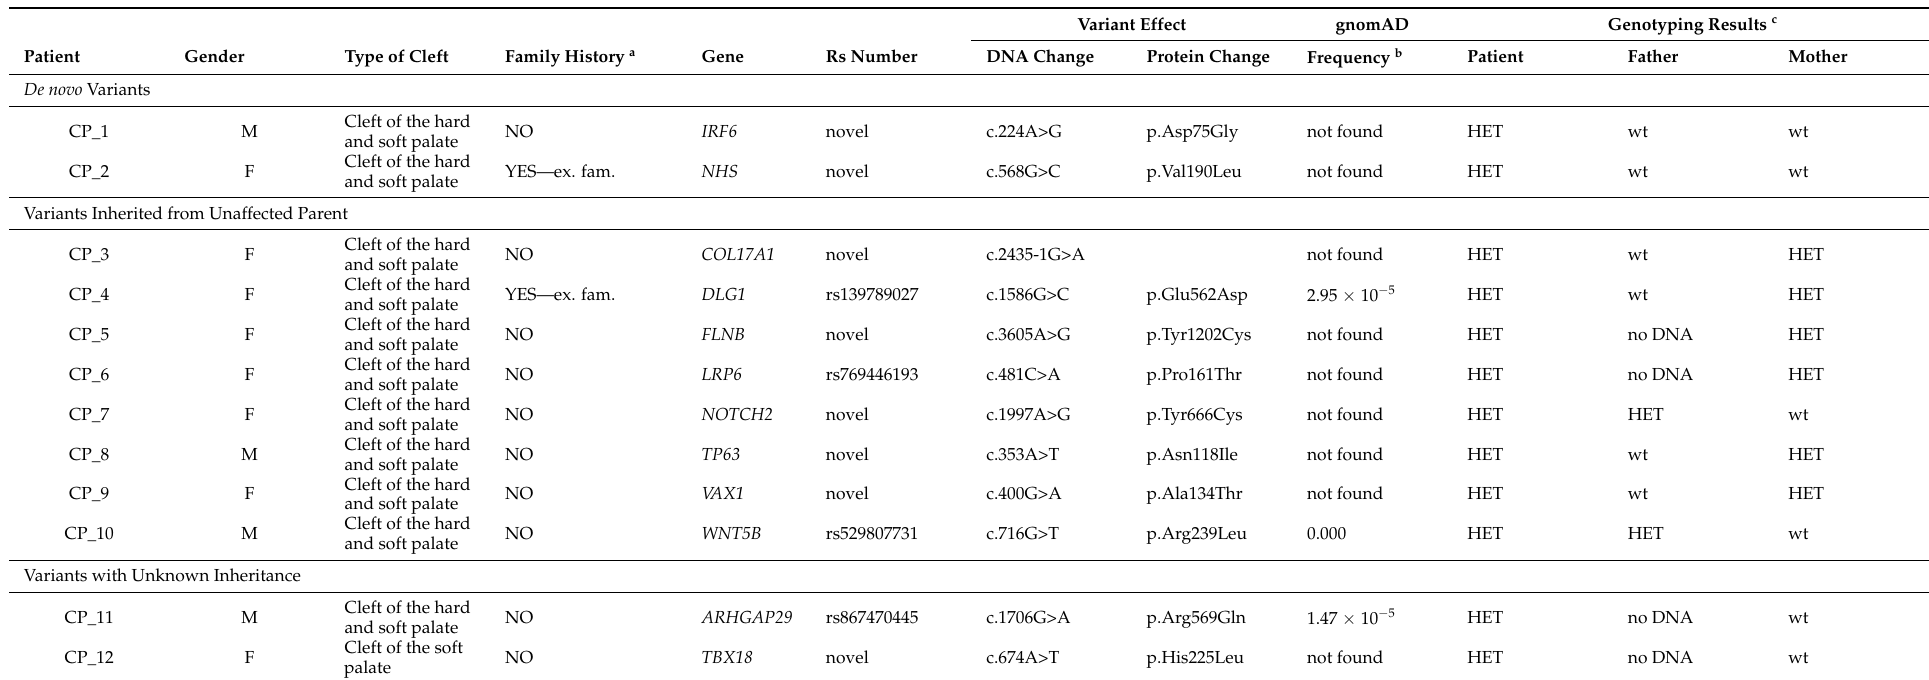
Table 2. Nucleotide variants identified in patients with